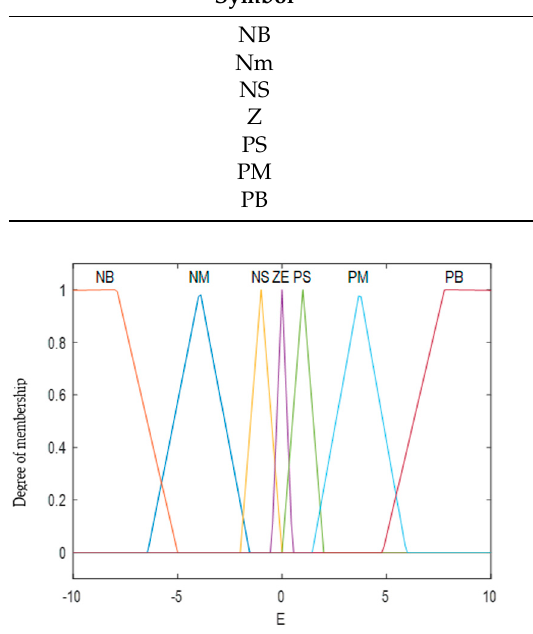
Figure 3. Membership function of fuzzy input.